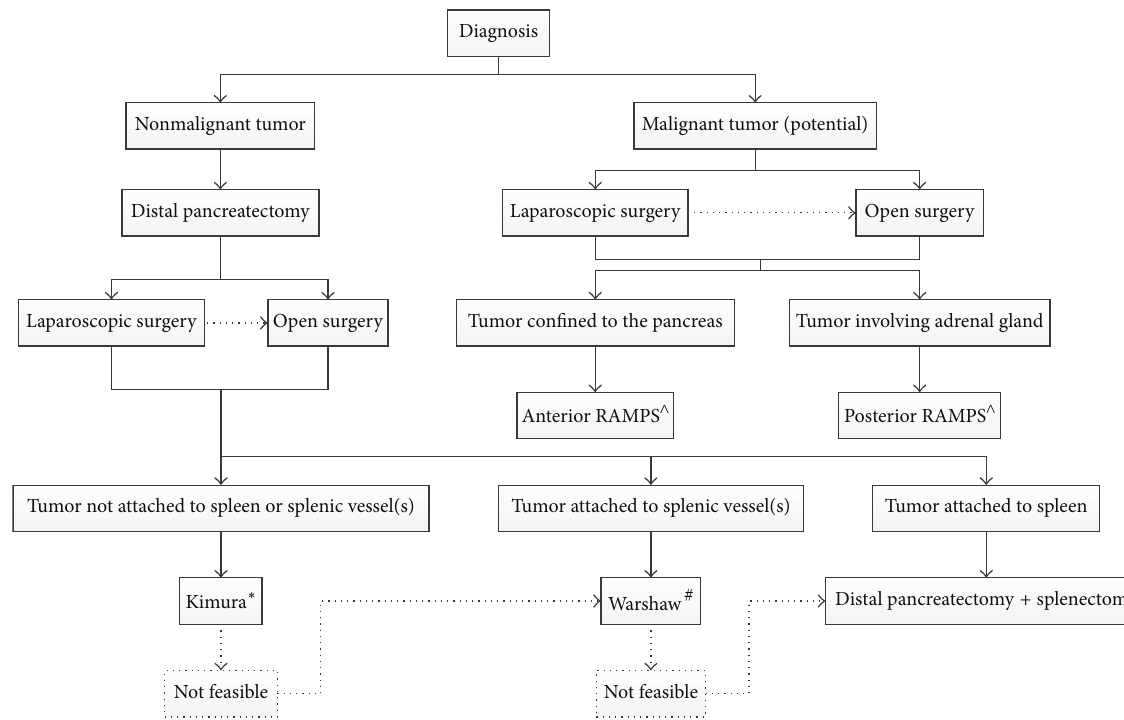
Figure 2: Flow chart indicating preferred surgical technique. Dotted lines are optional pathways. Laparoscopic procedures can convert to open surgery. ∗ Kimura = spleen-preserving distal pancreatectomy with preservation of the splenic vessels. # Warshaw = spleen-preserving distal pancreatectomy with resection of the splenic vessels. ∧ RAMPS = radical antegrade modular pancreatosplenectomy.